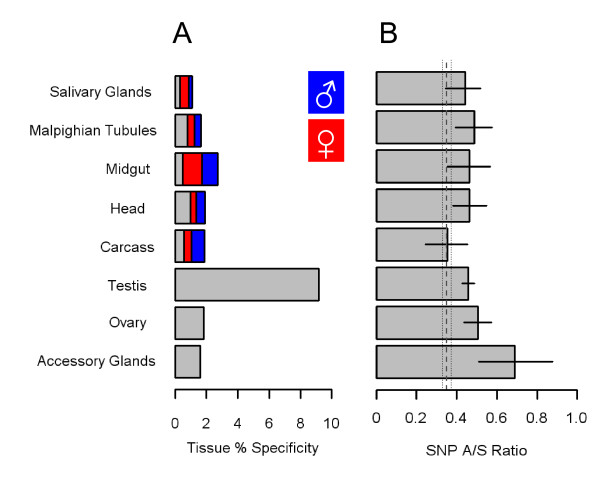
Tissue-specific expression patterns. (A) Tissue specific transcription was investigated on the basis of probe detection (3 out of 4 mismatch calls). Instances where probes were detected in a single tissue and a single sex are also highlighted: Female (red), male (blue). (B) SNP A/S ratio for genes with tissue-specific expression. 95% C.I. was estimated with 10,000 bootstrapped replicates.